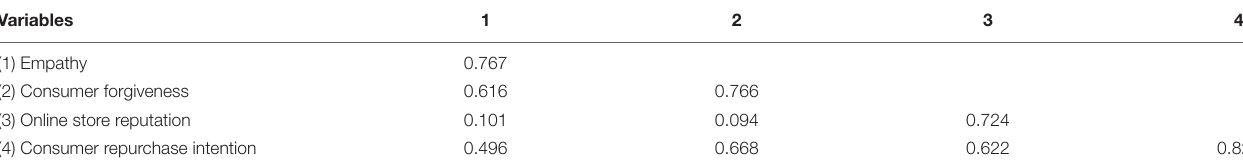
TABLE 3 | Test for discriminant validity.